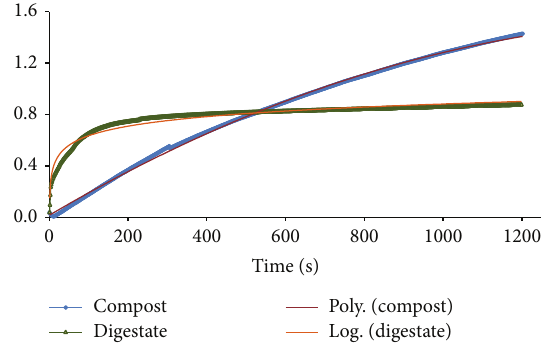
Figure 2: Time evolution of wettability of compost and digestate.